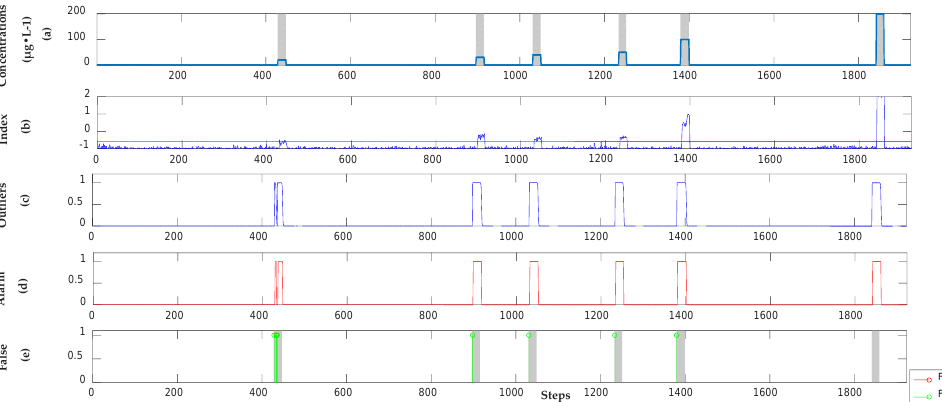
Figure 5. The detection results of m-phenylenediamine in the semi-supervised model. ( a ) Location and concentration of each event; ( b ) Alarm signals, which exceeded the threshold shown as the red dotted line; ( c ) Outliers obtained by using SVR; ( d ) Alarm sequences triggered by Sequential Bayesian; ( e ) FP points and FN points compare with real categories.